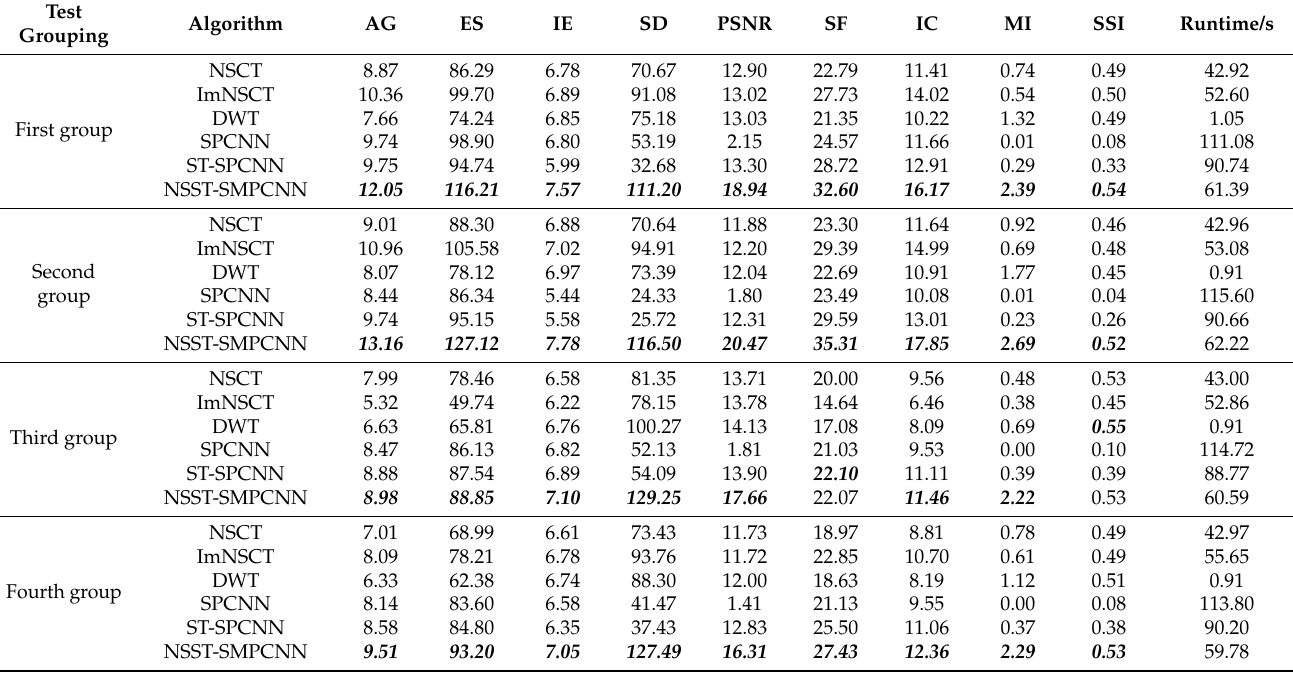
Table 5. Objective evaluation index results of dataset